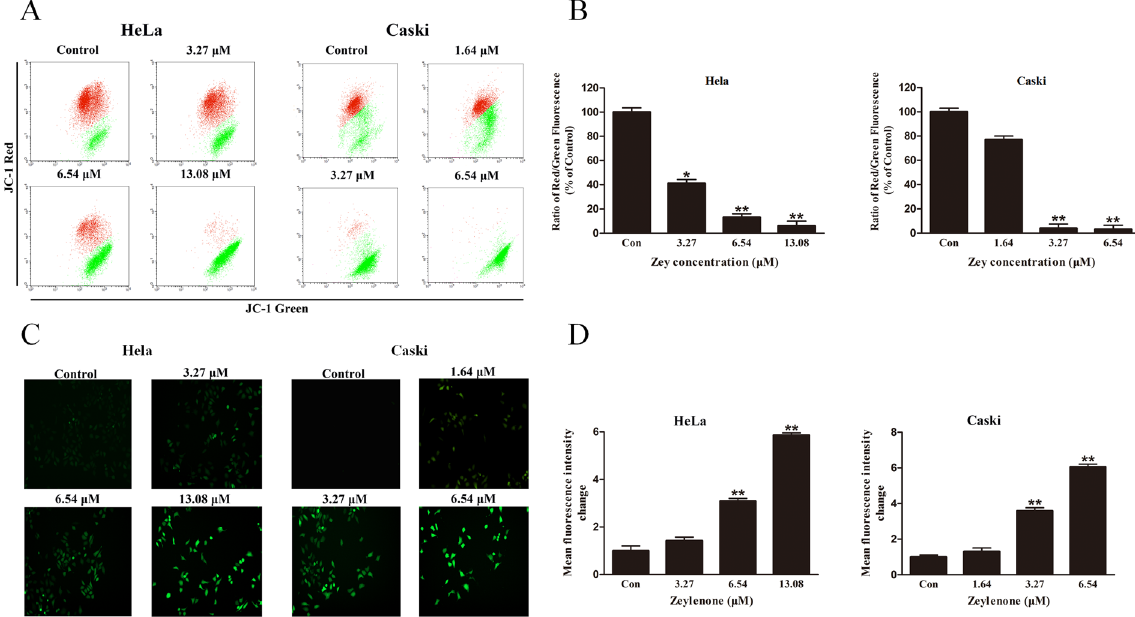
Figure 6. Zey induced mitochondrial dysfunction and ROS production. ( A ) Zey induced loss of mitochondrial membrane potential in HeLa and CaSki cells. Cells were treated with increasing concentrations of Zey for 24 h, mitochondrial membrane potential were analyzed after cells were stained with JC-1. ( B ) Quantitative analysis of the ratio of red to green fluorescence. Data were presented as the means ± SD for triplicate determinations. * P < 0.05, ** P < 0.01 versus control cells. ( C ) ROS production was detected by fluorescence microscope after HeLa and CaSki cells were treated with Zey for 24 h. ( D ) Statistical analysis of fluorescence intensity after cells were stained with